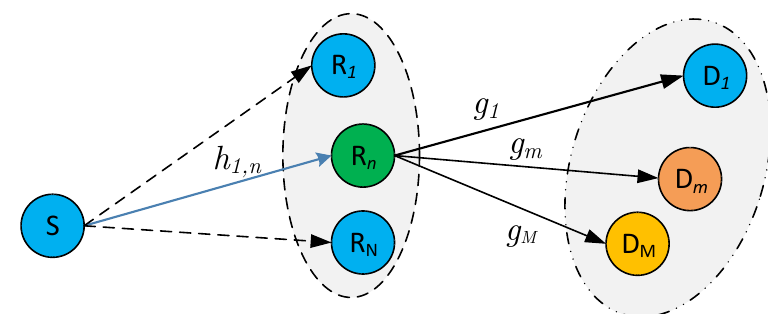
Figure 1. System model of downlink non-orthogonal multiple access (NOMA) relaying system with simultaneous wireless information and power transfer